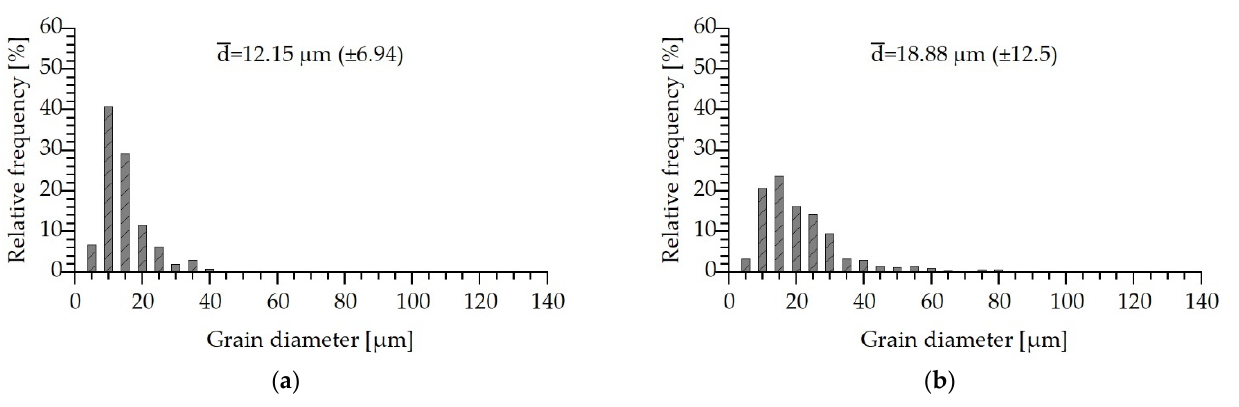
Figure 6. Grain size distribution of the twin-roll cast and heat-treated (460 °C/15 min) magnesium wire pre-profile AZ31, ( a ) edge area and ( b ) wire centre.